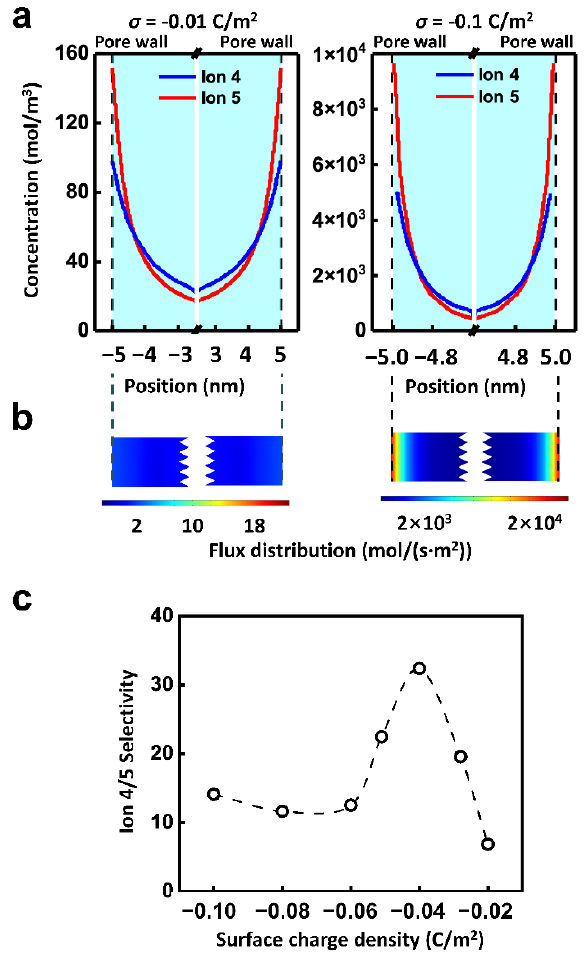
Figure 5. Effect of surface charge. ( a ) The radial concentration distribution of Ion 5 suggests that, the surface charge density largely affects the ion concentration distribution. The ion concentration near the pore wall is much higher than that in the center of the pore, indicating the importance of EDL. ( b ) The distribution of ionic flux in the channel. ( c ) The selectivity is regulated by the surface charge density. The well-matched multi-physics field condition and surface charge density can improve the selectivity ratio. The calculation condition is 0.01 V and 0.5 MPa.